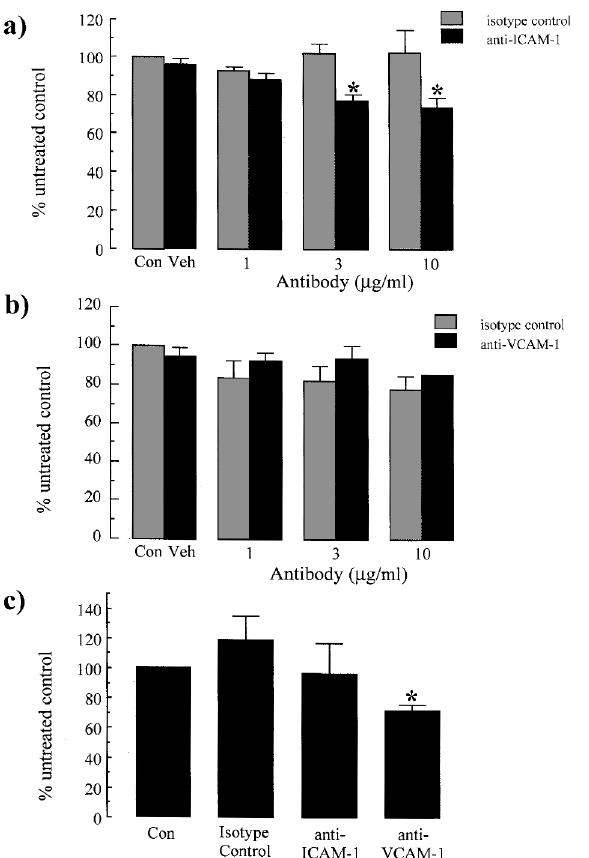
FIG. 2. Eosinophil adhesion to airway smooth muscle cells in the presence of antibodies to the adhesion molecules: ( a ) ICAM-1 (mouse IgG2b, clone LB-2), and ( b ) VCAM-1 (mouse IgG1, clone E1/6) for 20h of co-culture, or ( c ) ICAM-1 (mouse IgG1, cloneHA58) and VCAM-1 (mouse IgG1, clone51–10C9) for 2h of co-culture or irrelevant antibodies with the same isotypes. Values are means ± SE; Con, untreated control; Veh, antibody vehicle control; *, significantly different from the relevant isotype control ( p < 0.05, n = 4).